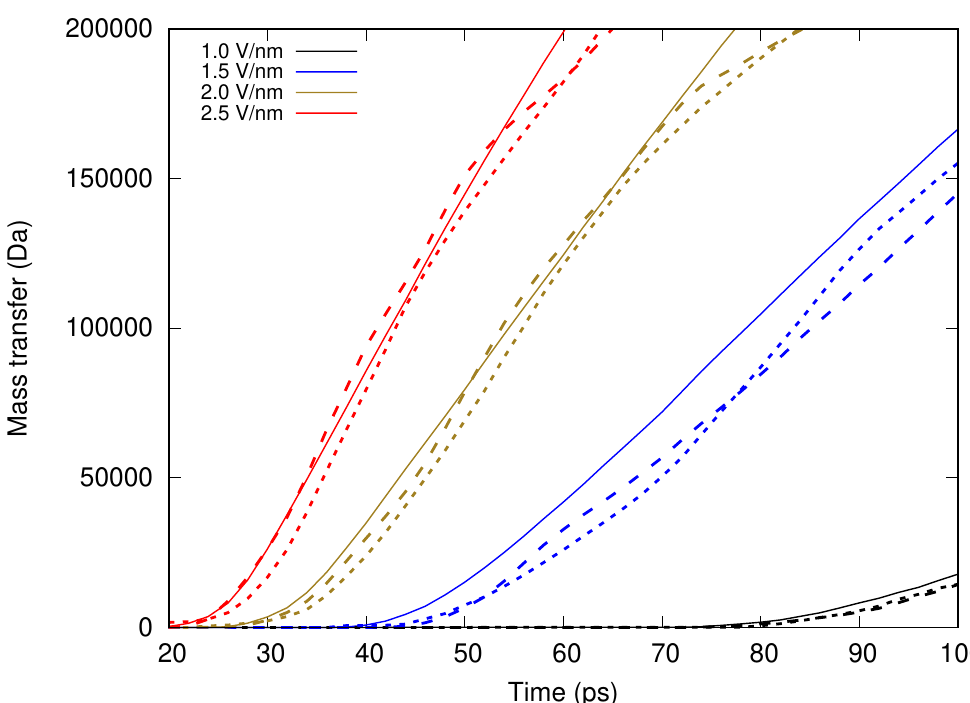
Figure 12. Mass transported through the plane at z = 20 nm as a function of production time for different intensities of the applied electric field (color coded, see the legend). Samples with eight 5.26-kDa PEG chains and 0 (full line), 18 (short-dashed line), or 36 (long-dashed line) NaCl ion pairs are used. Plotted with gnuplot [56].